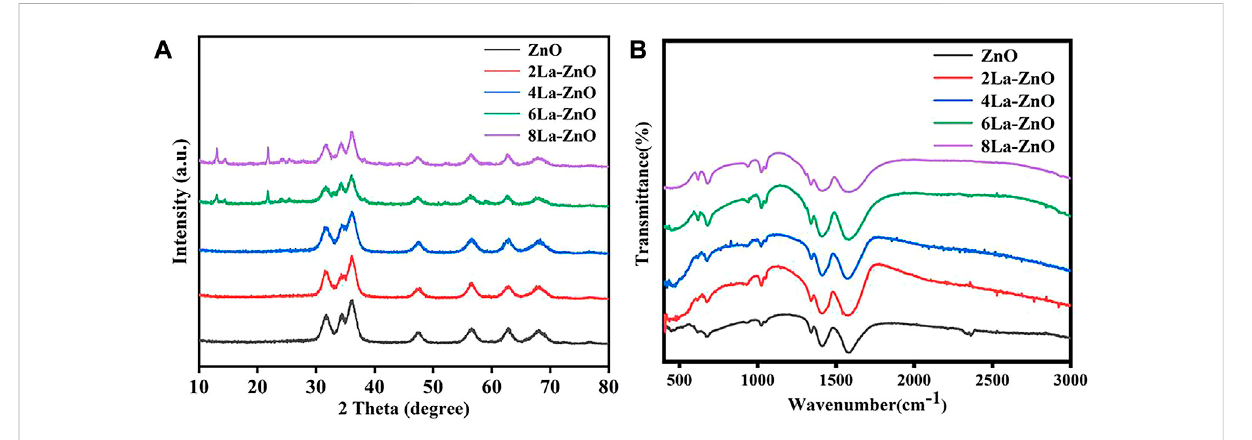
FIGURE 3 (A) XRD pattern and (B) FTIR spectra of pure ZnO and La-ZnO